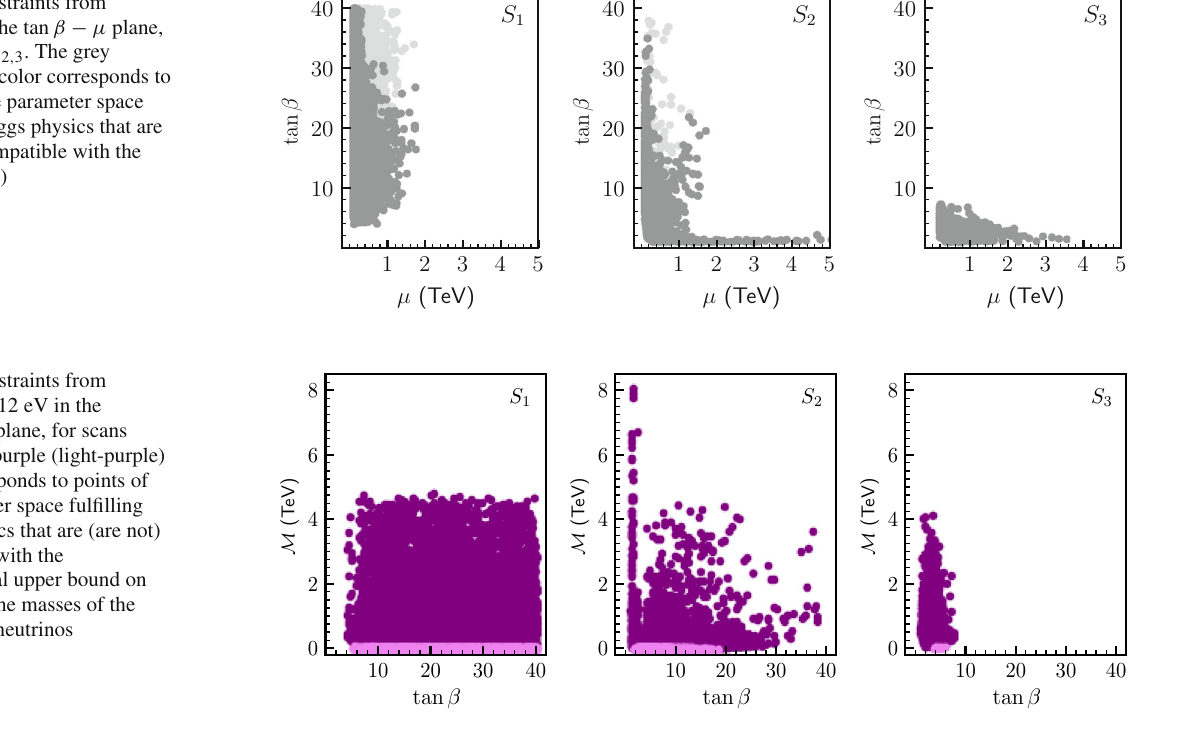
Fig. 1 Constraints from b → s γ in the tan β − μ plane, for scans S 1 , 2 , 3 . The grey (light-grey) color corresponds to points of the parameter space fulfilling Higgs physics that are (are not) compatible with the BR( b → s γ )